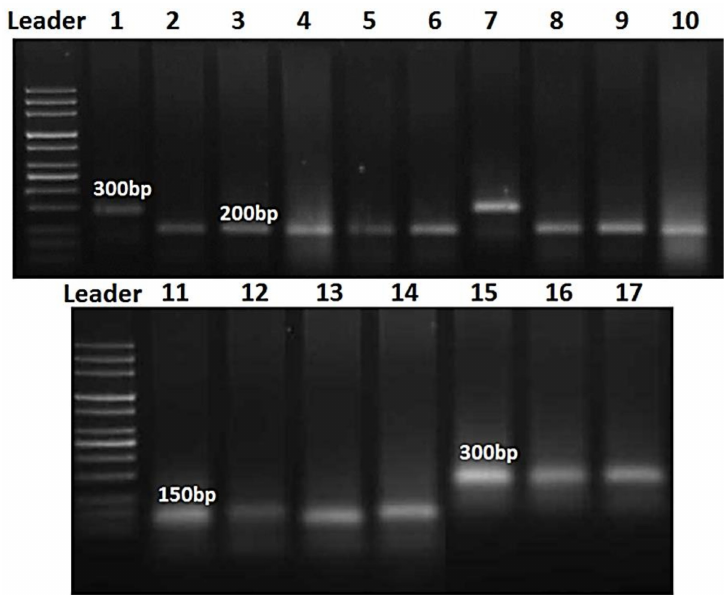
Figure 6. PCR electrophoretic amplification of 17 races of Puccinia tritinia genomic DNA.